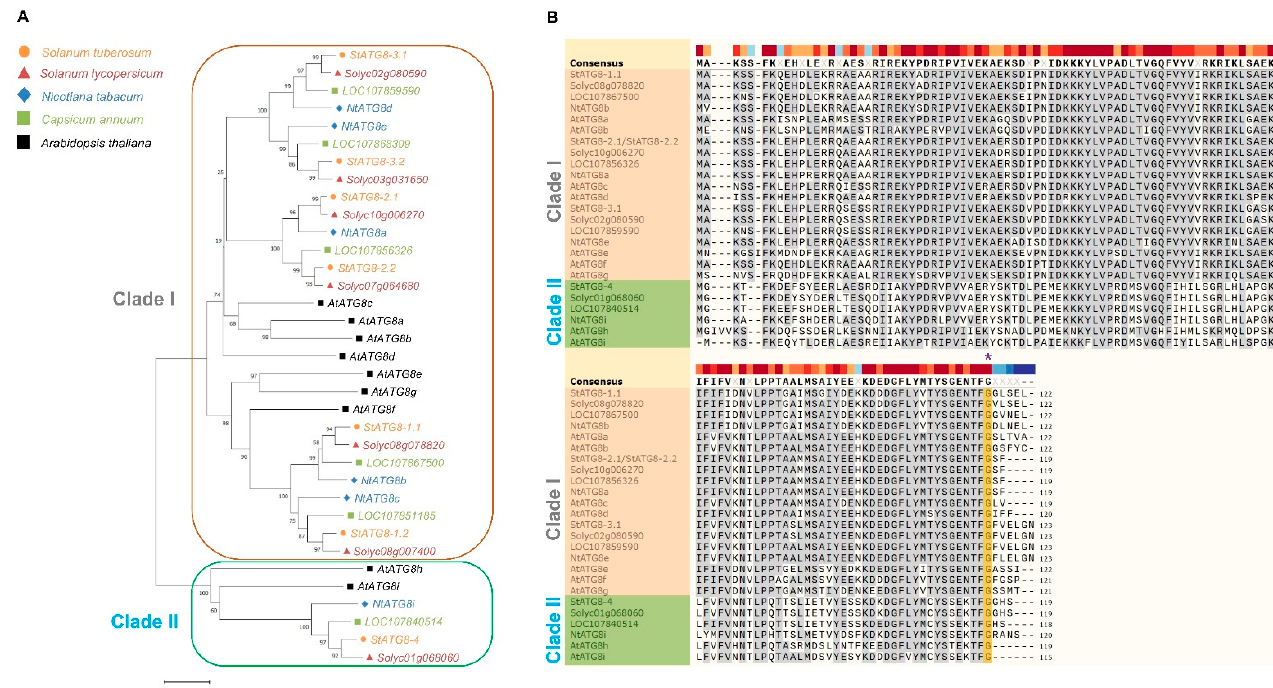
Figure 1. Potato StATG8 family divided into two group with other plant species. (A). Phylogenetic relationships of ATG8s from Solanum tuberosum with those of Nicotiana tabacum , Solanum lycopersicum , Capsicum annuum , and Arabidopsis thaliana . The tree was constructed from an analysis conducted with MEGA-X software using a maximum likelihood method. Phylogenetic tree was based on the nucleotide sequence data. Numbers along the branches (bootstrap value) show the percentage occurrence of nodes in 1000 replicates of stimulation. Sequences of ATG8 genes: StATG8-1.1 ;